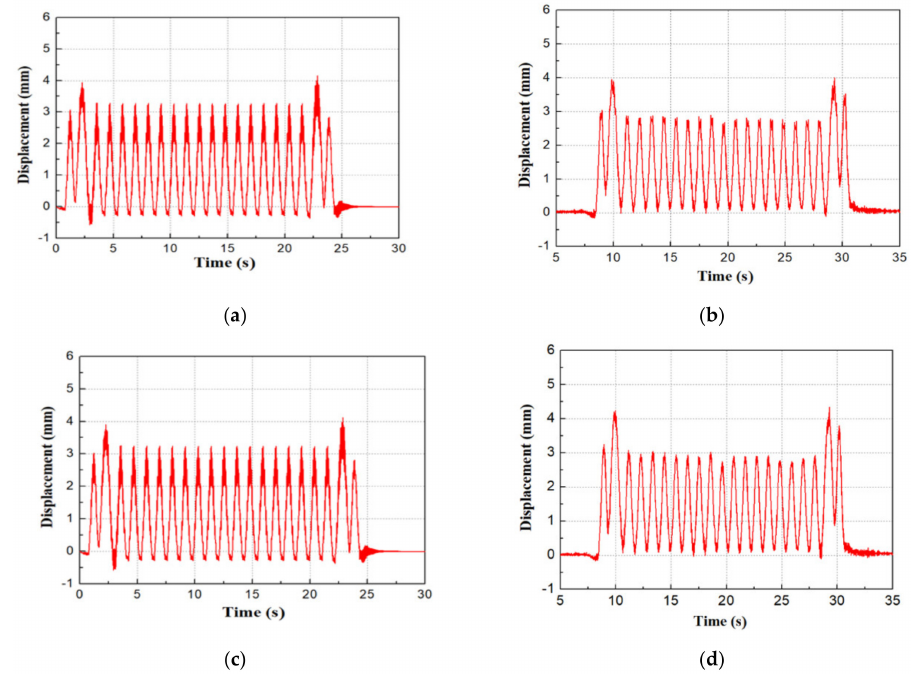
Figure 5. Comparison of rail and track girder vertical displacements. ( a ) Rail vertical displacement (100 km / h, numerical analysis); ( b ) Rail vertical displacement (98 km / h, field measurement); ( c ) Track girder vertical displacement (100 km / h, numerical analysis); ( d ) Track girder vertical displacement (98 km / h, field measurement).